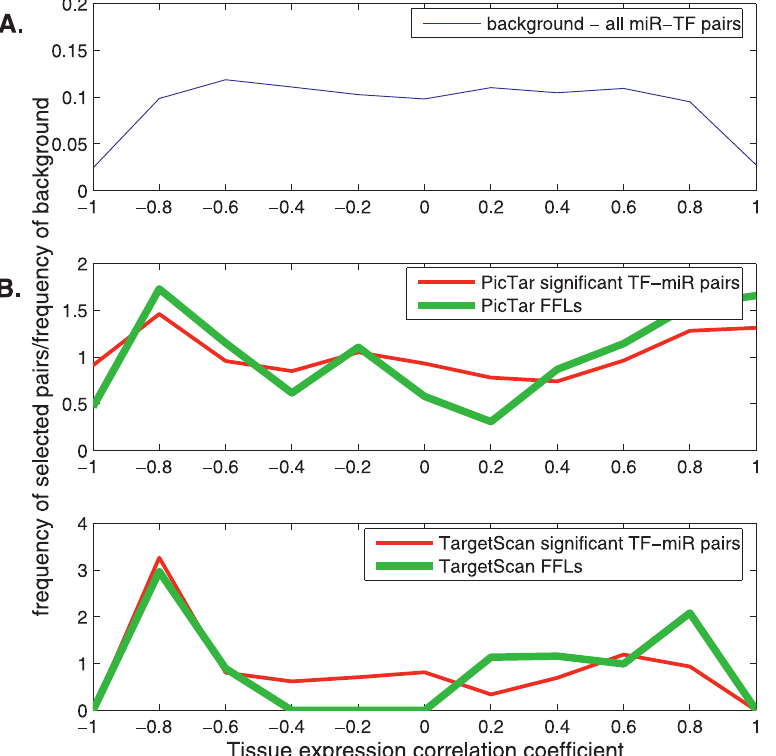
Figure 5. Tissue Expression Correlations between miRs and TFs miR tissue expression in brain, liver, thymus, testes, and placenta were taken from [34]. mRNA tissue expression was taken from [35]. (A) Background distribution of all possible miR–TF pairs for which expression profiles can be derived. (B,C) Normalized histograms of correlation coefficients; the same distribution as in (A) was made, yet only for significantly co-occurring miR-TF pairs (red), and FFLs (green) in the PicTar (B) and TargetScan (C) networks. The figure shows the proportion of the various correlation coefficients divided by the background distribution depicted in (A).